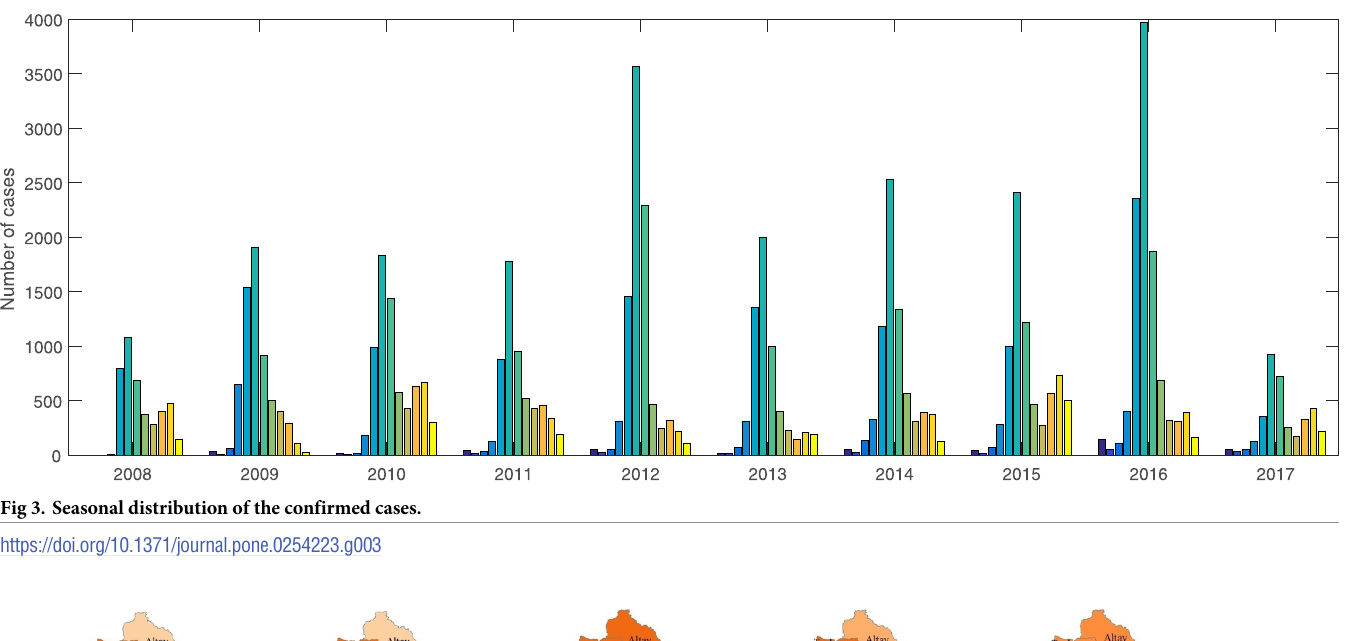
Fig 3. Seasonal distribution of the confirmed cases.